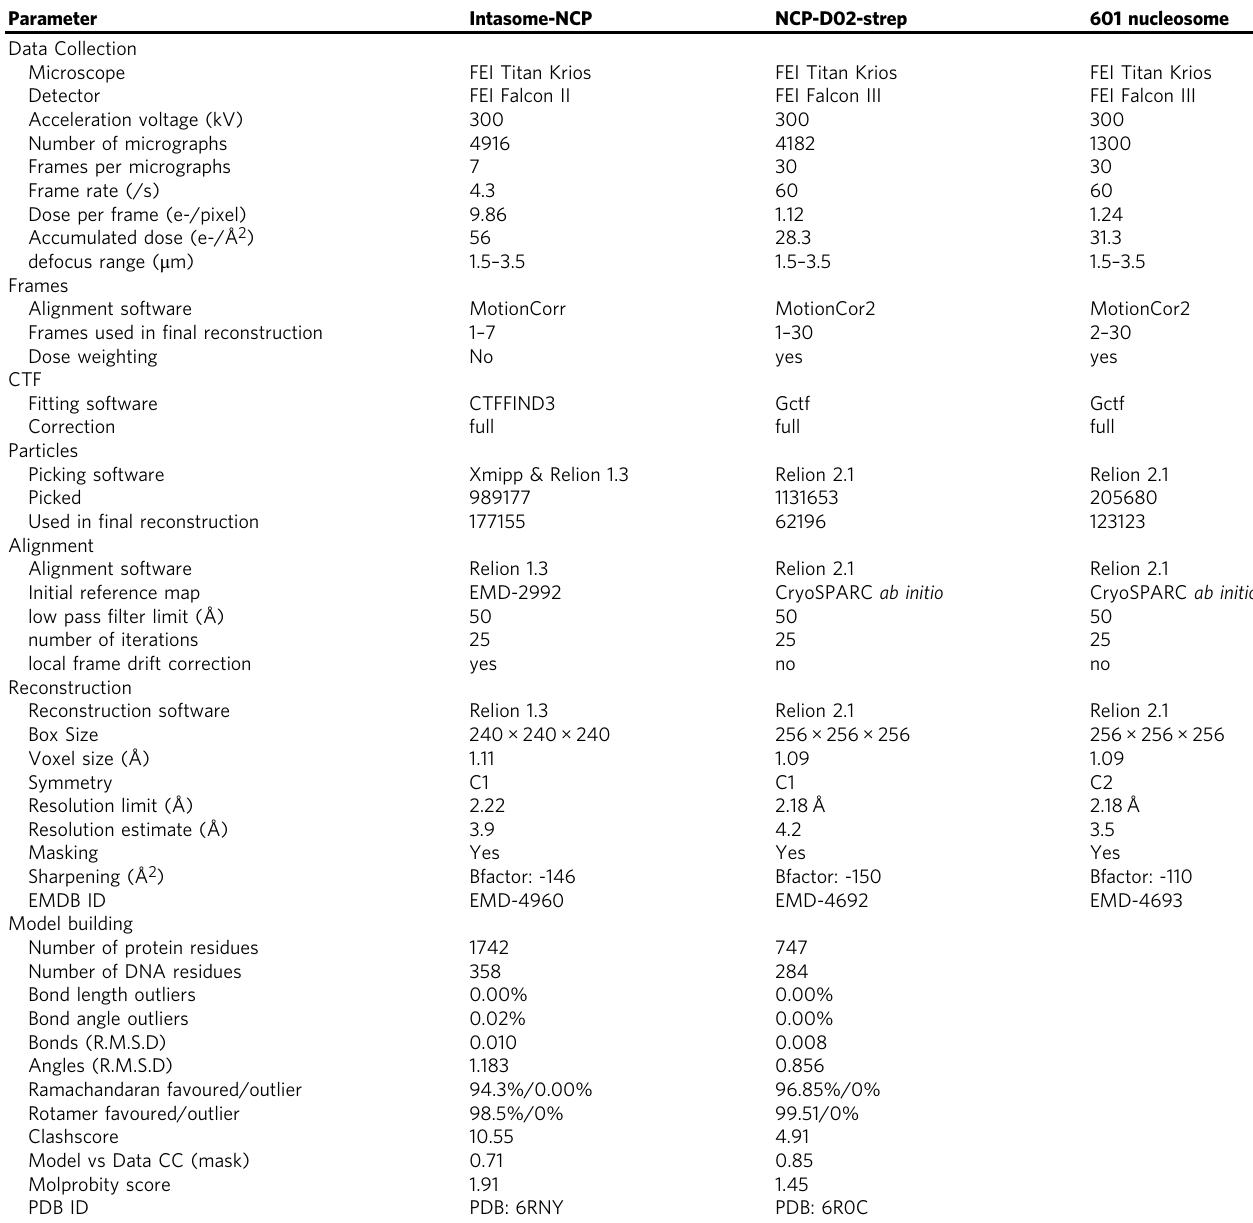
of H2A Lys-9 and Arg-11 with the IN C-terminal domain (Fig. 2a). Concordantly, truncation of the fi rst 12, but not 8 H2A residues lead to a reduction of intasome-NCP complex formation (Fig. 2b). Furthermore, Ala substitutions of either H2A at Lys-9 or Arg-11 affect complex stability, while a combination of the two substitutions fully abrogated stable complex formation under conditions of the pull-down assay (Fig. 2c). Asymmetric reconstruction of the human D02 NCP . Similar to the pre-catalytic complex, our new structure of an intasome-NCP strand-transfer complex features a nucleosomal DNA loop bul- ging away from the protein octamer by ~7 Å at the integration site. Although occurring at a different superhelical location, the DNA looping is reminiscent of structures of NCPs engaged by